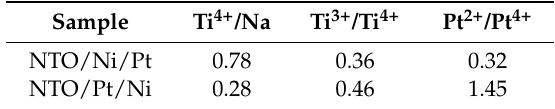
Table 1. XPS ratios obtained from NTO/Ni/Pt and NTO/Pt/Ni